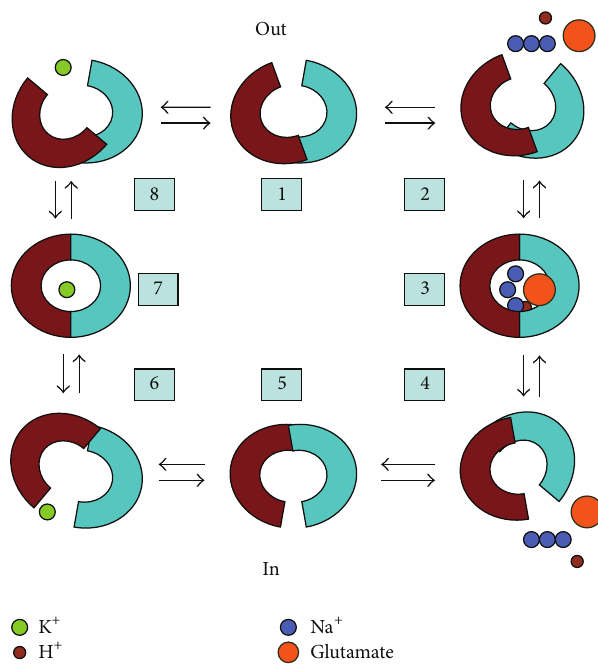
Figure 1: The mode of EAATs action. In the normal condition, the outward facing empty glutamate transporter (1) binds with glutamate, H + , and 3 Na + (2) and turns into the fully loaded carrier state (3). Followed by releasing the substrates at the intracellular face (4), the transporter turns into the inward facing empty state (5). Thereafter, K + binds to the inward facing transporter (6) and turns into the K + loaded transporter state (7). Afterwards, the transporter releases K + at the extracellular face (8) and translocates back into the outward facing empty glutamate transporter state